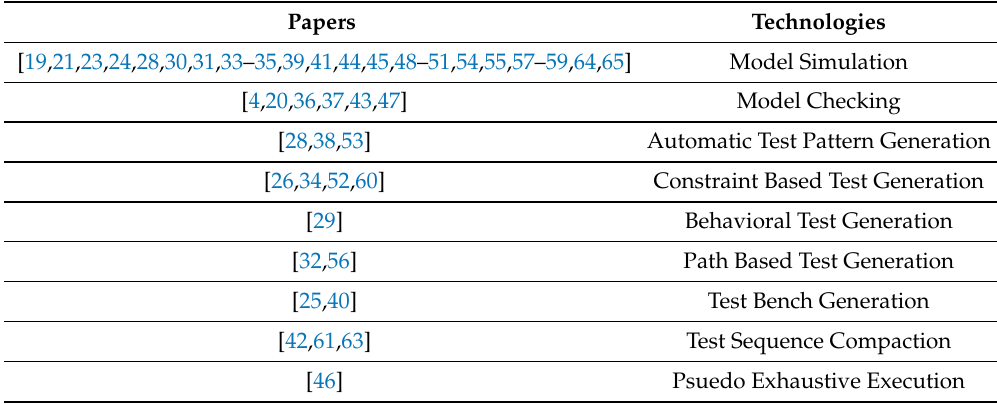
Table 4. Classification of the studies under the different technologies